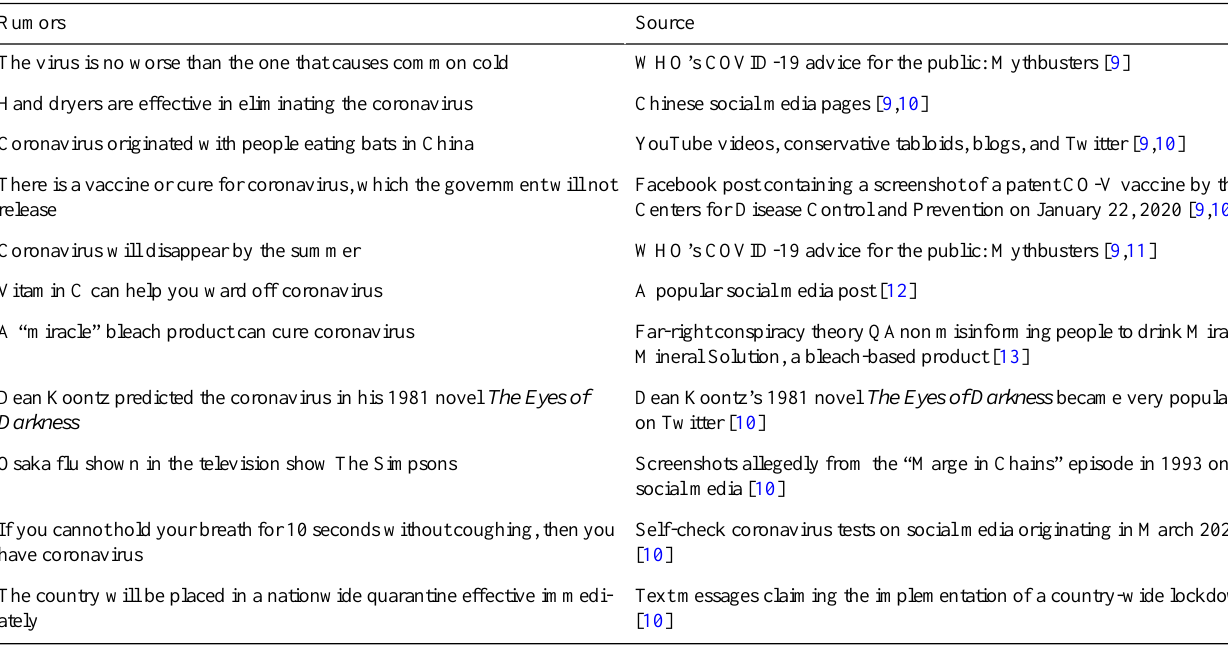
Table 1. Rumors related to COVID-19 emergence and